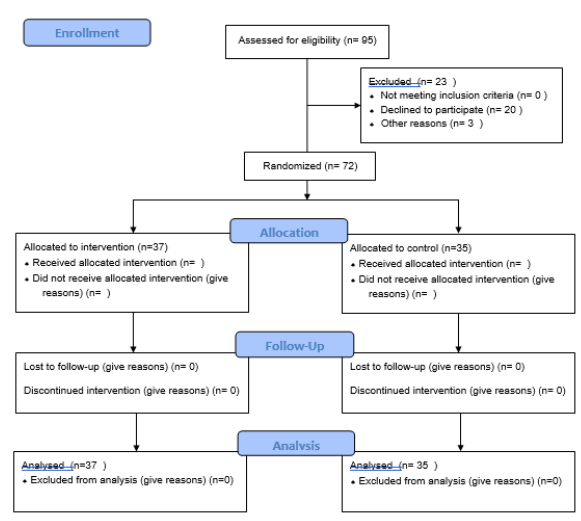
Figure 1 CONSORT Flow Diagram